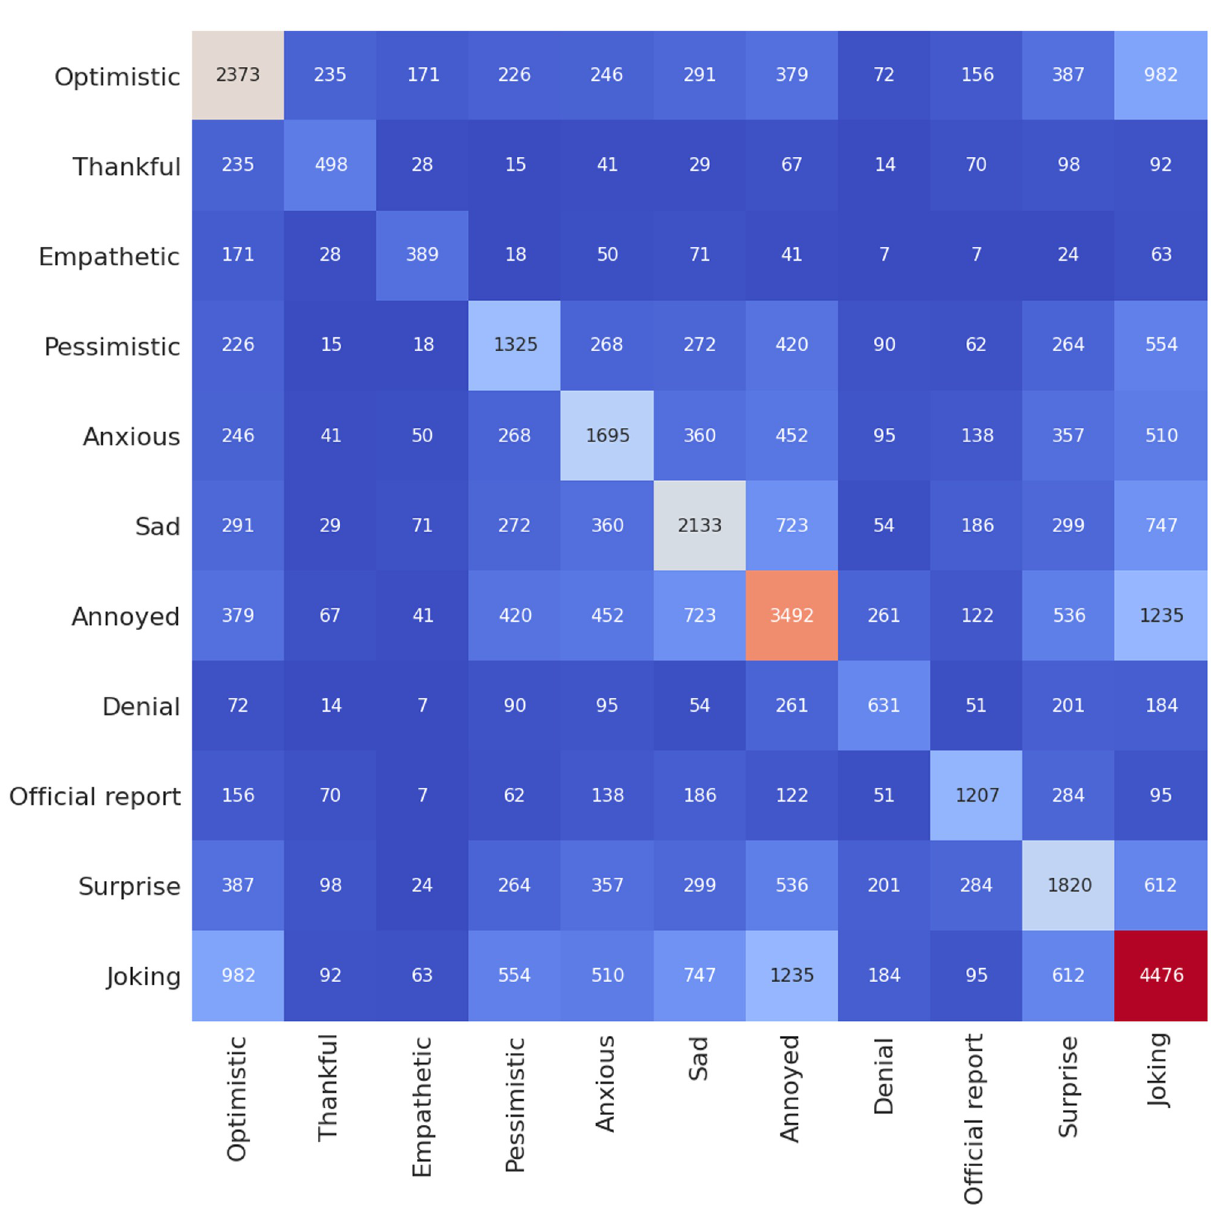
Fig 4. Heatmap showing number of occurrence of a given sentiment in relation to the rest of the sentiments for 10,000 tweets from Senwave dataset [45] used for training.